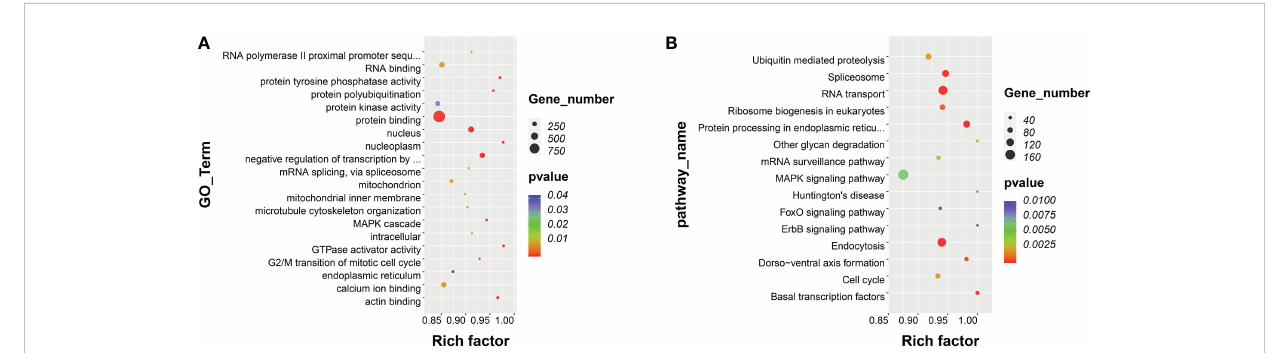
FIGURE 4 (A) Scatter plot showing the top 20 enriched GO terms, resulting from the DMGs between CS and HS. (B) Scatter plot showing the top 15 enriched KEGG pathways, resulting from the DMGs between CS and